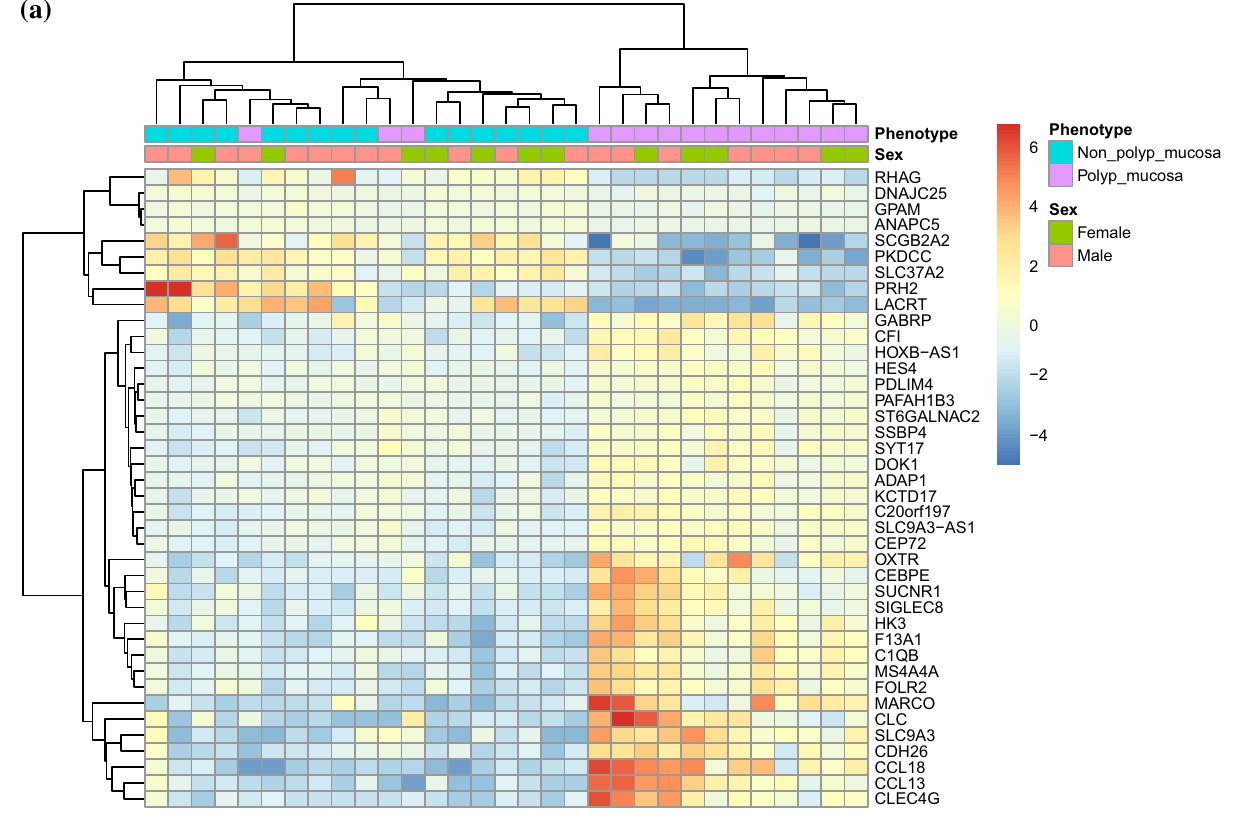
Figure 2. Heatmap of the 40 most differentially expressed genes (DEGs). ( a ) Polyp mucosa versus non-polyp mucosa from the same CRSwNP patient and ( b ) Healthy control patient mucosa versus non-polyp mucosa from CRSwNP patient. DESeq2 R package analysis, including sex and age as covariates. Heatmaps were generated using “pheatmap” in R, R version